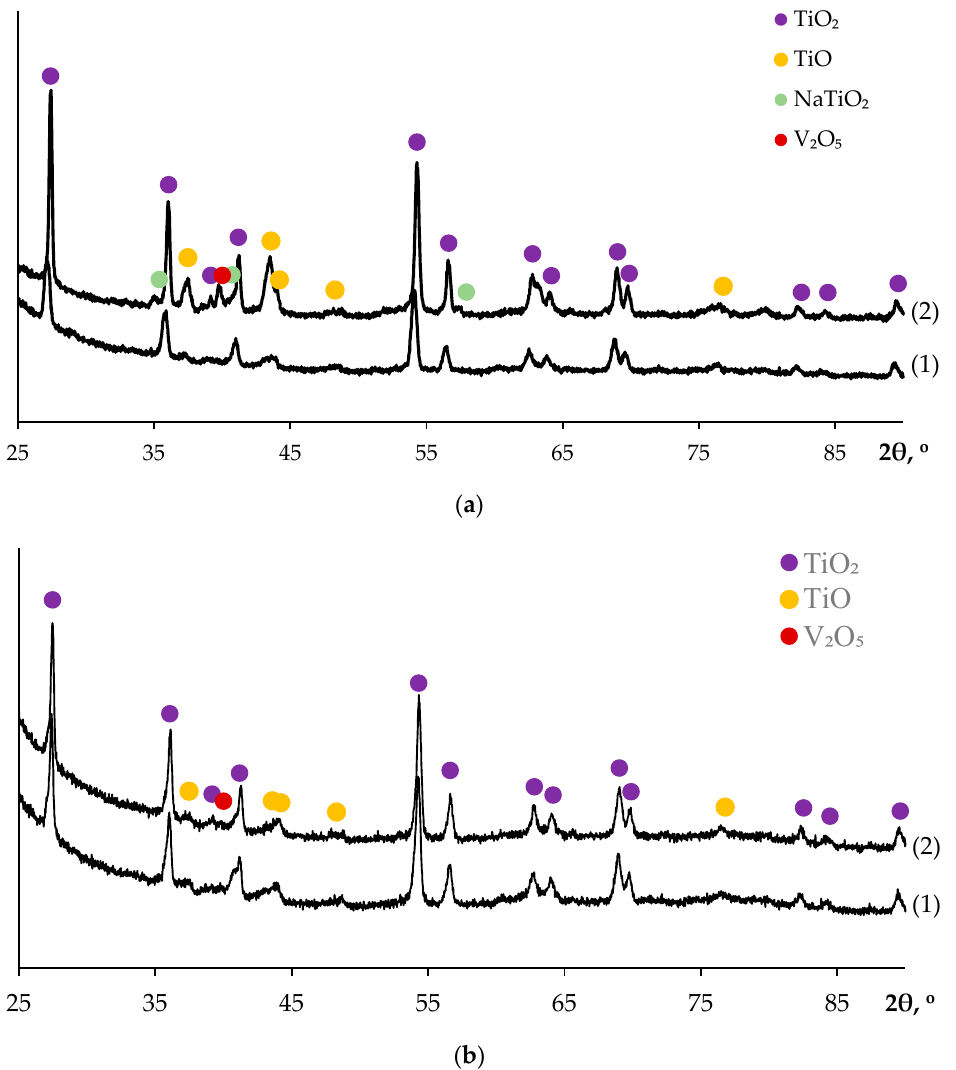
Figure 10. Results of XRD analysis of the corrosion products on the surfaces of the specimens of coarse-grained ( a ) and UFG ( b ) alloys after HSC testing. The numbers (1) and (2) in Fig. (a) and (b) correspond to samples #1 and #2 (see Fig. 1b,c).